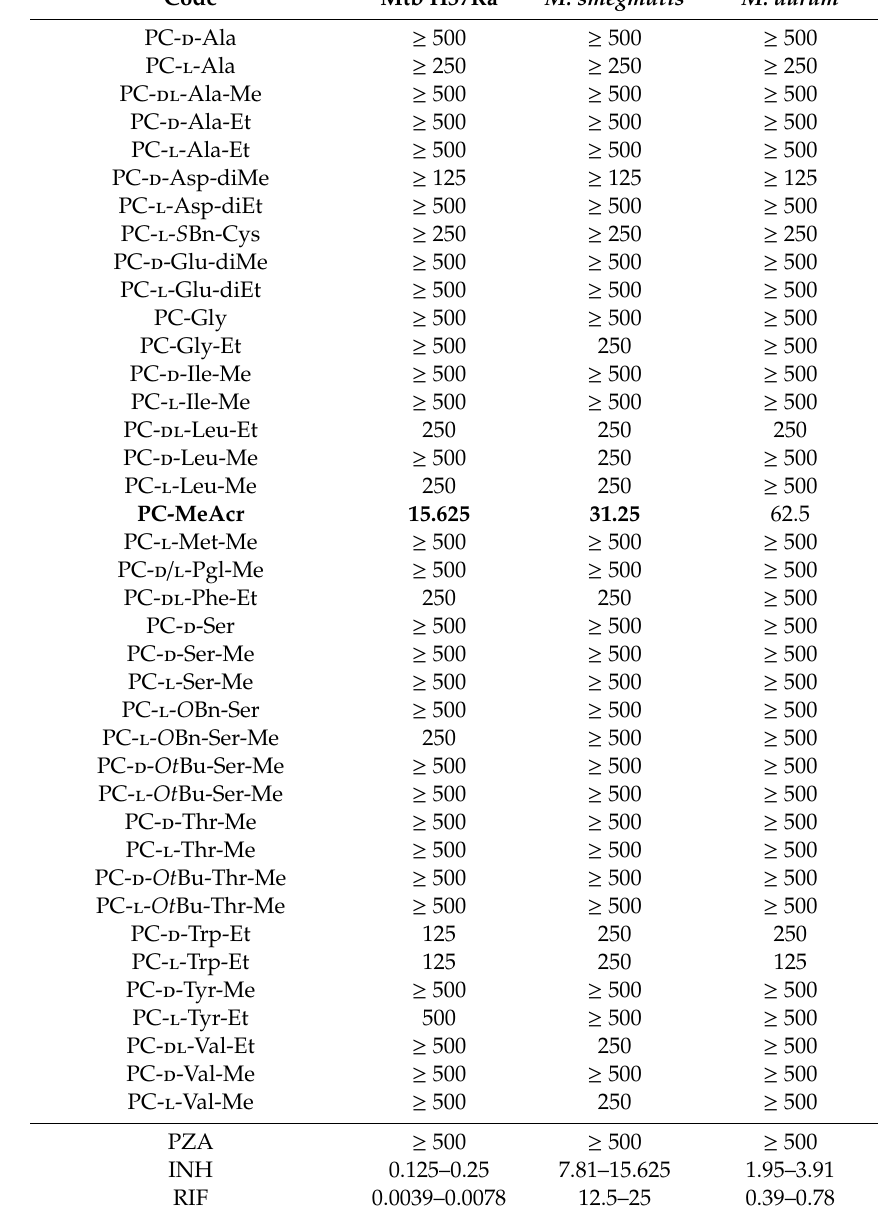
Table 2. Antimycobacterial activities of the tested compounds at pH 6.6 presented as the minimum inhibitory concentration (MIC) ( µ g / mL), the most active compound is in bold. The chemical structures of the derivatives are presented in Table